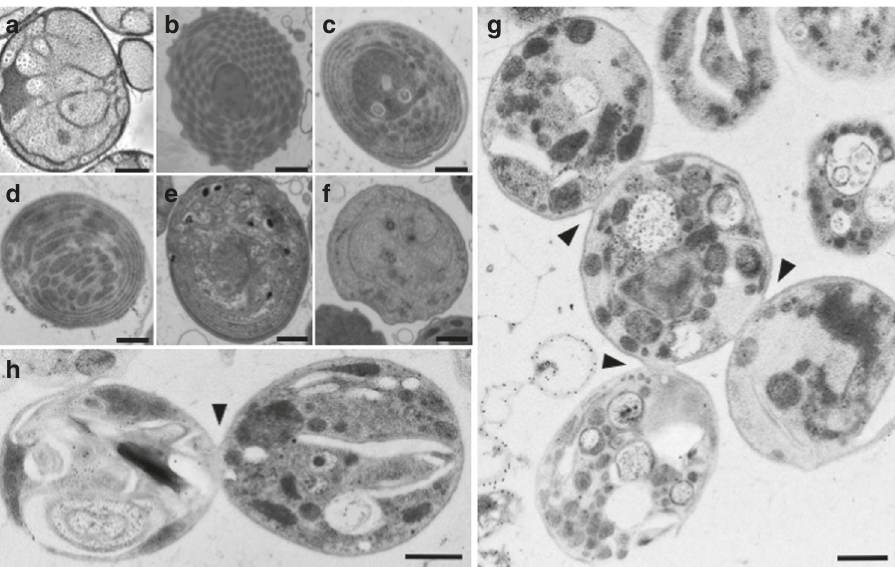
Fig. 2 Transmission electron microscopy of G. obscuriglobus cells de fi cient in sterol synthesis. Representative membrane phenotypes observed in the G. obscuriglobus mutant interrupted in the sqmo gene. Wild-type cell ( a ). Various membrane organizations are shown, including b cellular space crowded with small vesicles, c stacks of membrane layers inside the cytoplasm, d multiple elongated sausage-like structures, e , f or a mixture of these and unde fi ned features, g multiple budding. g , h Arrows indicate necks between dividing cells. Black dots correspond to localization of the GFP used to interrupt the sqmo gene. Scale bar represents 0.5 μ m